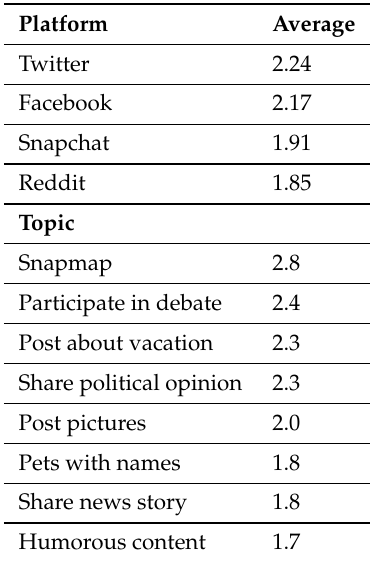
Table 16. The aggregated average risk perceptions sorted from high to low for the platforms and